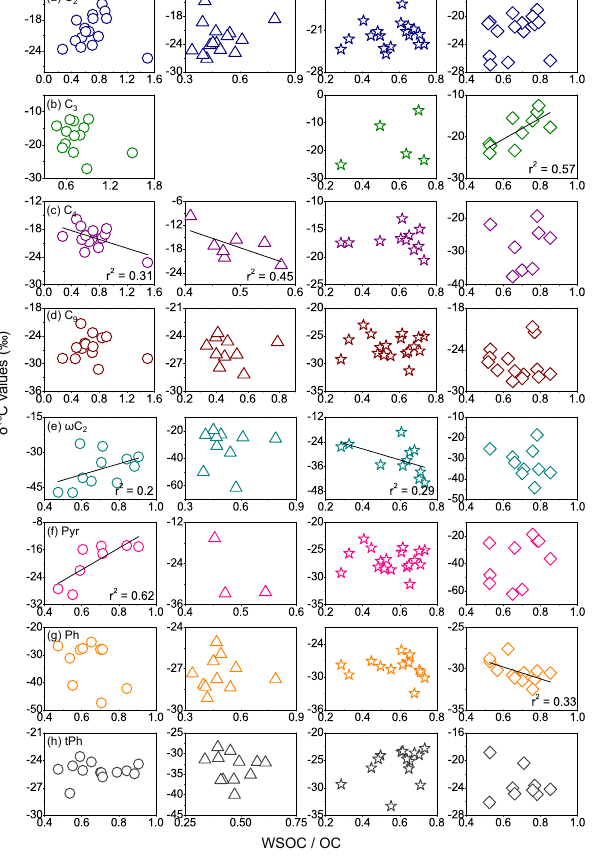
Figure 10. Correlations between δ 13 C of selected diacids and oxoacids and WSOC / OC ratios in PM 2 . 5 in